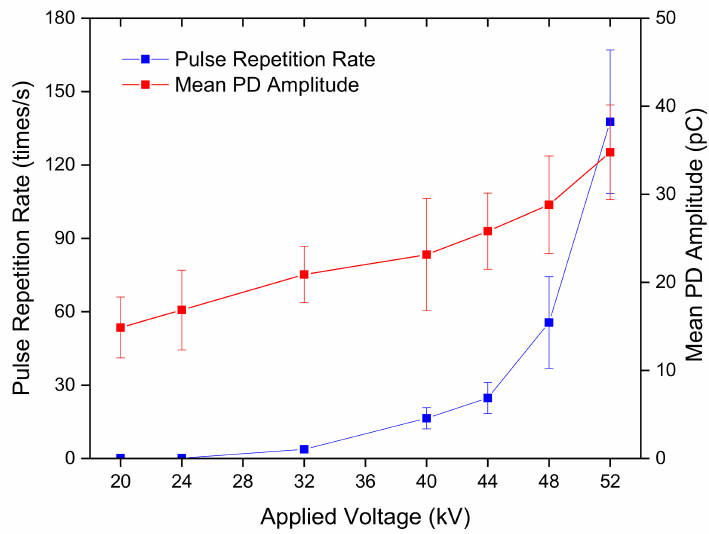
Figure 11. PD parameters under AC/DC proportion of 1:7.